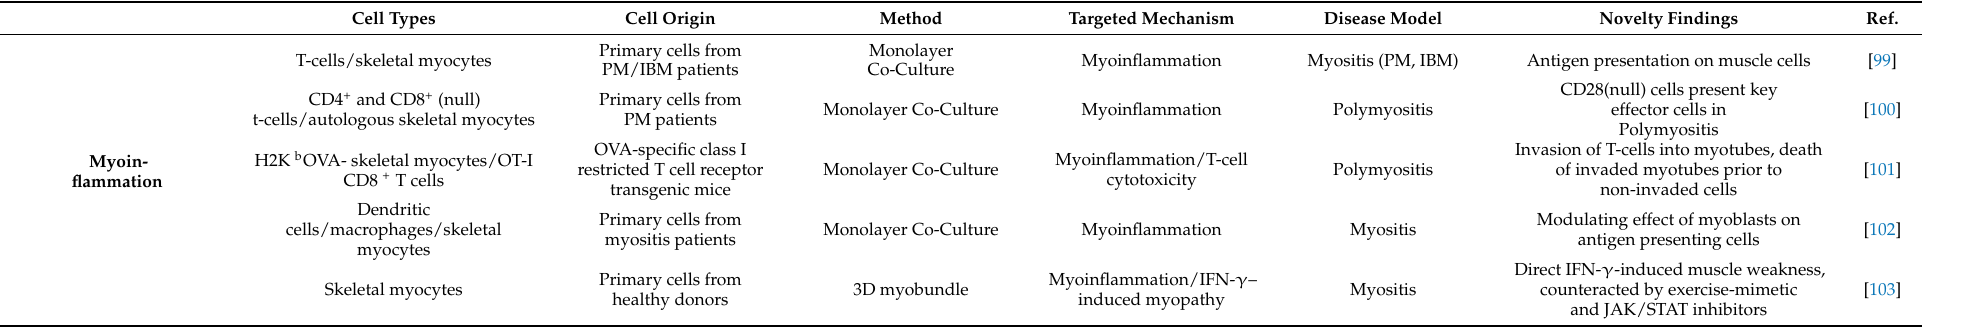
Table 1. Established in vitro models of neuromuscular diseases . Focus on myoinflammatory, muscular dystrophy, and neuromuscular disease